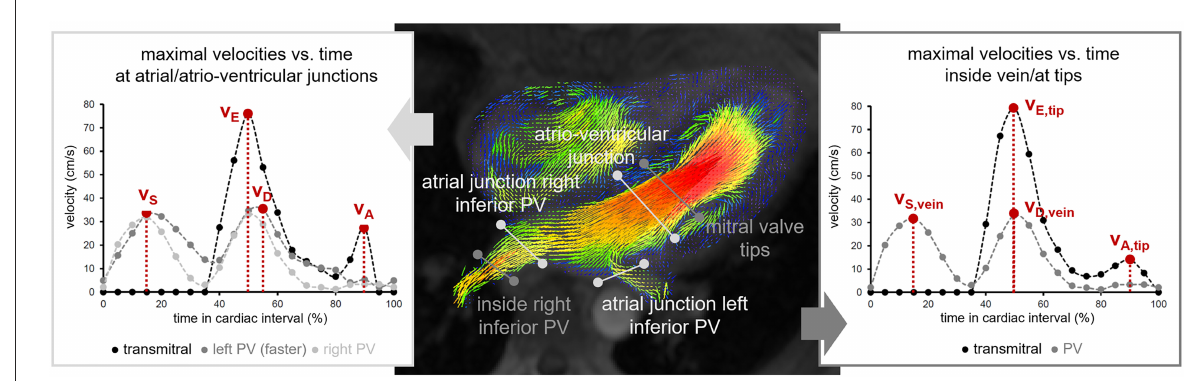
FIGURE1 Illustration of the determination of LA peak in- and outflow velocities. Measurement cut planes are indicated on an early diastolic magnitude image with color-encoded vector plot of the three-dimensional velocity field. PV pulmonary vein; v S , systolic LA peak inflow velocity; v D , diastolic LA peak inflow velocity; v E , early diastolic LA peak outflow velocity; v A , late diastolic LA peak outflow velocity; v S,vein , systolic peak velocity determined in the pulmonary vein; v D,vein , diastolic peak velocity determined in the pulmonary vein; v E,tip , early diastolic peak velocity determined at the level of the mitral valve tips; v A,tip , late diastolic peak velocity determined at the level of the mitral valve